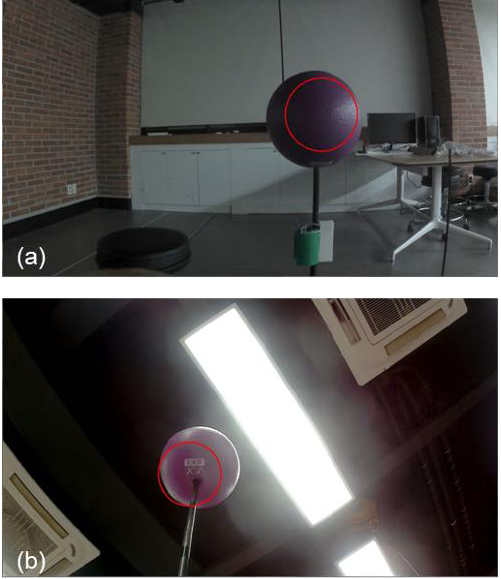
Figure 4. Inaccurate detection with HSV filtering under harsh lighting conditions. ( a ) Dark space with insufficient directional lighting; ( b ) bright space with excessive backlight.